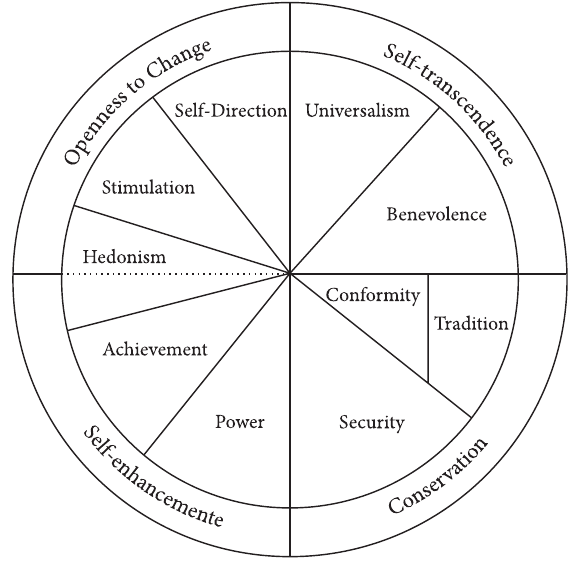
Figure 1. Universal structure of personal